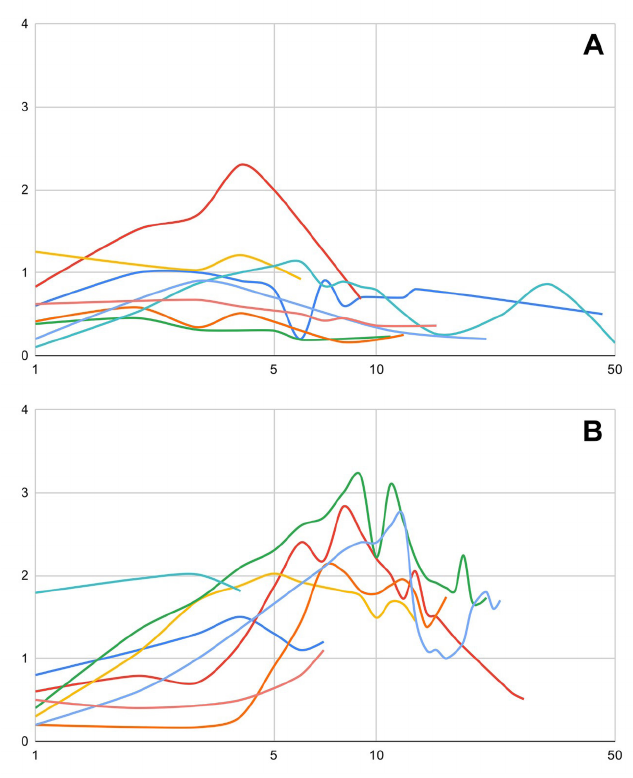
Fig. 3 - Serum creatinine trend in patients who were weaned from extracorporeal life support (ECLS). X axis shows days from surgery in logarithmic scale, Y axis shows serum creatinine in mg/dl. A) Serum creatinine trend in patients who were successfully weaned from ECLS and survived to hospital discharge. B) Serum creatinine trend in patients who were successfully weaned from ECLS but did not survive.